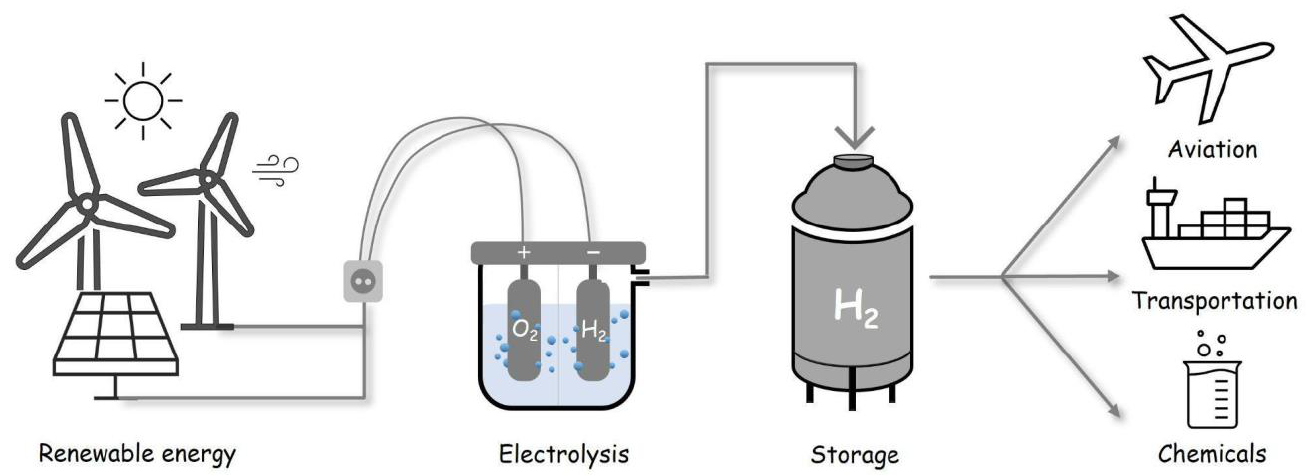
Figure 1. Representation of green hydrogen technology.